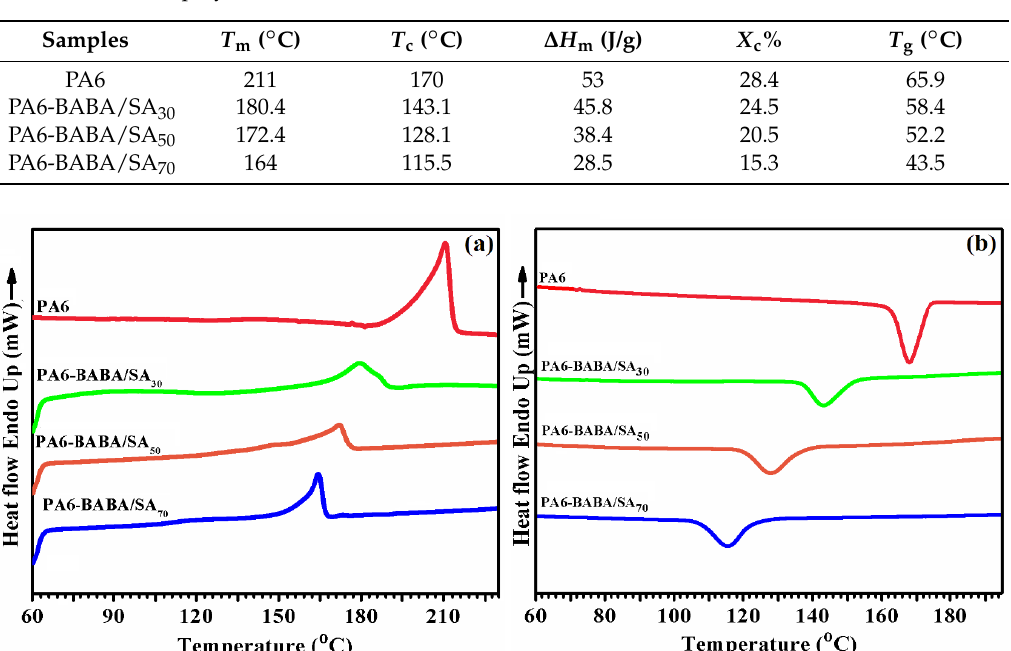
Figure 5. Dynamic mechanical analysis (DMA) analysis of virgin PA6 and PA6-BABA/SA copolyamides.